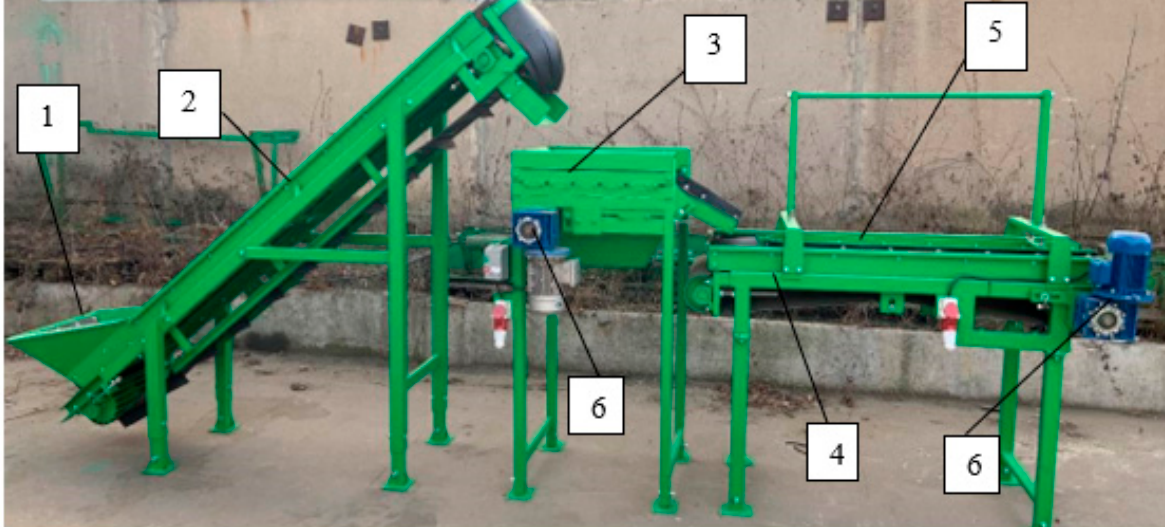
Figure 3. Photograph of a machine for the post-harvest processing of potato tubers with an automated sorting system: 1—receiving hopper; 2—transfer conveyor; 3—spiral heap cleaner; 4—sorting table; 5—conveyor belts; 6—electric motors.